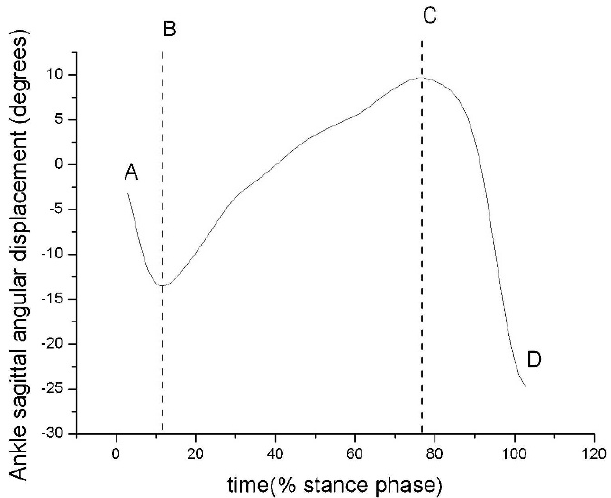
Figure 2 - Subphases of the gait stance obtained from ankle sagittal angular variation: the initial heel contact occurred between A and B, the midstance phase occurred between B and C, and the propulsion phase occurred between C and D. Positive values denote ankle flexion, and negative values denote